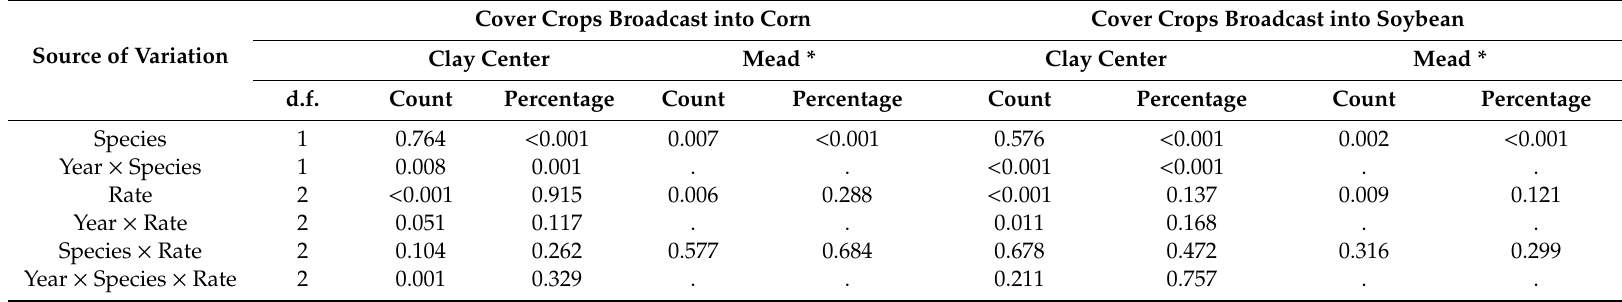
Table 3. Source of variation (cover crop species, year, and cover crop seeding rate), degrees of freedom (d.f.) and p -values for cover crop stand counts, and the percentage of planted cover crops seeds that emerged. Seeds were broadcast interseeded into corn and soybean at two sites (Clay Center and